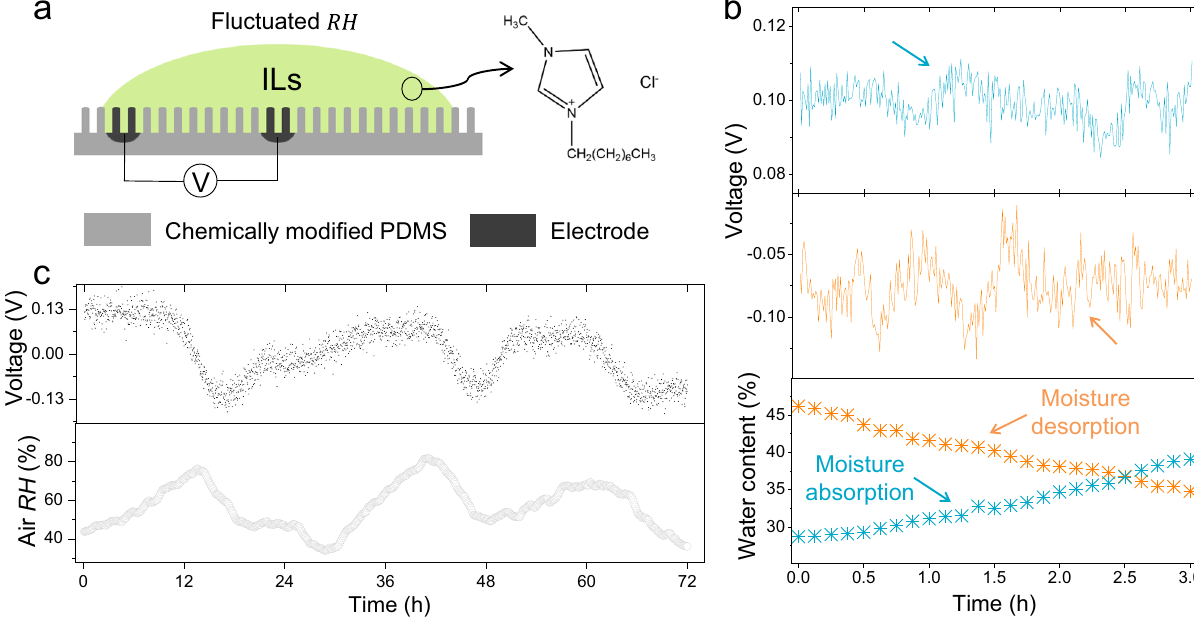
Fig. 1 Designing details and outdoor tests of the drop-based power generator. a Schematic illustration of the device with IL drop pinned on PDMS nanowire array and molecular structure of the selected IL. b V OC and IL drop WC curves indicating strong relation between moisture adsorption/desorption and power generation. c Continuous recording of V OC from above device in outdoor tests for 3 days. The surrounding RH is also